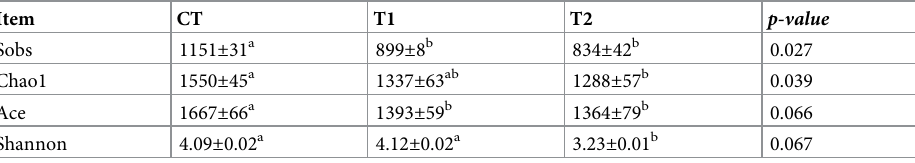
Table 3. Alpha diversity indices of the bacterial communities in food waste fermented products.